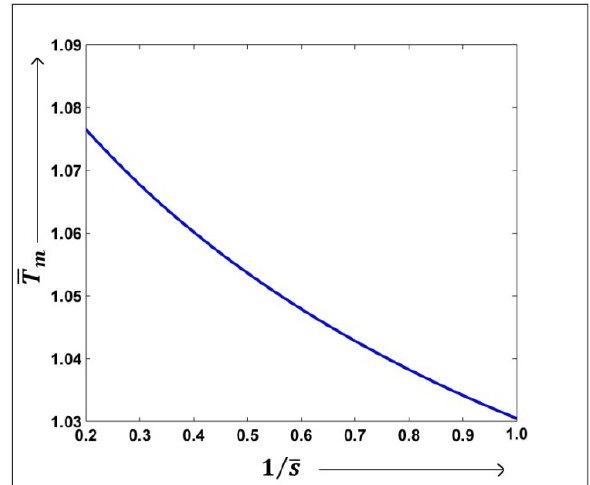
Fig. 3: Mean temperature vs. Slip parameter at ¯ β = 1.3, ¯ α 2 = 0.8, ¯ γ 2 = 1.2, P . E = 1.2, ¯ x = 0.6 r